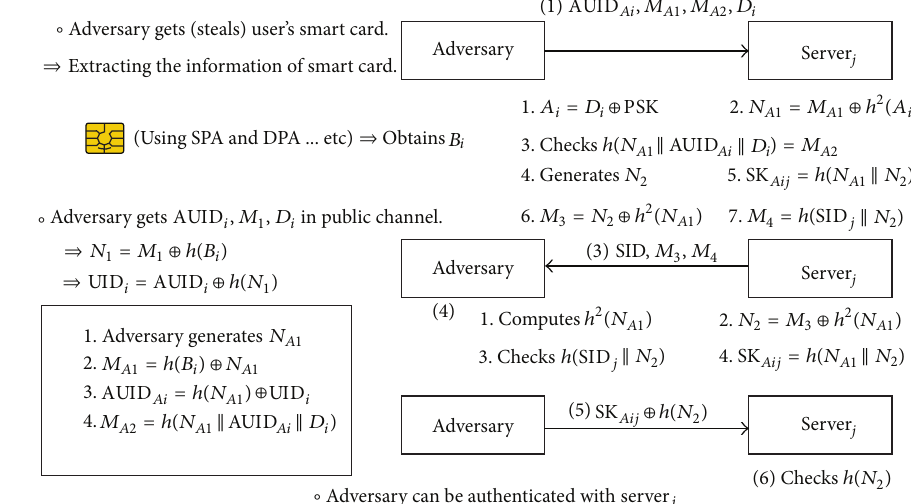
Figure 3: User impersonation attack on Chuang and Chen’s scheme.